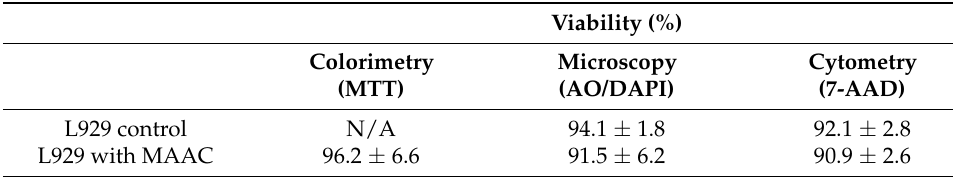
Table 4. Cytotoxicity of MAAC in L929